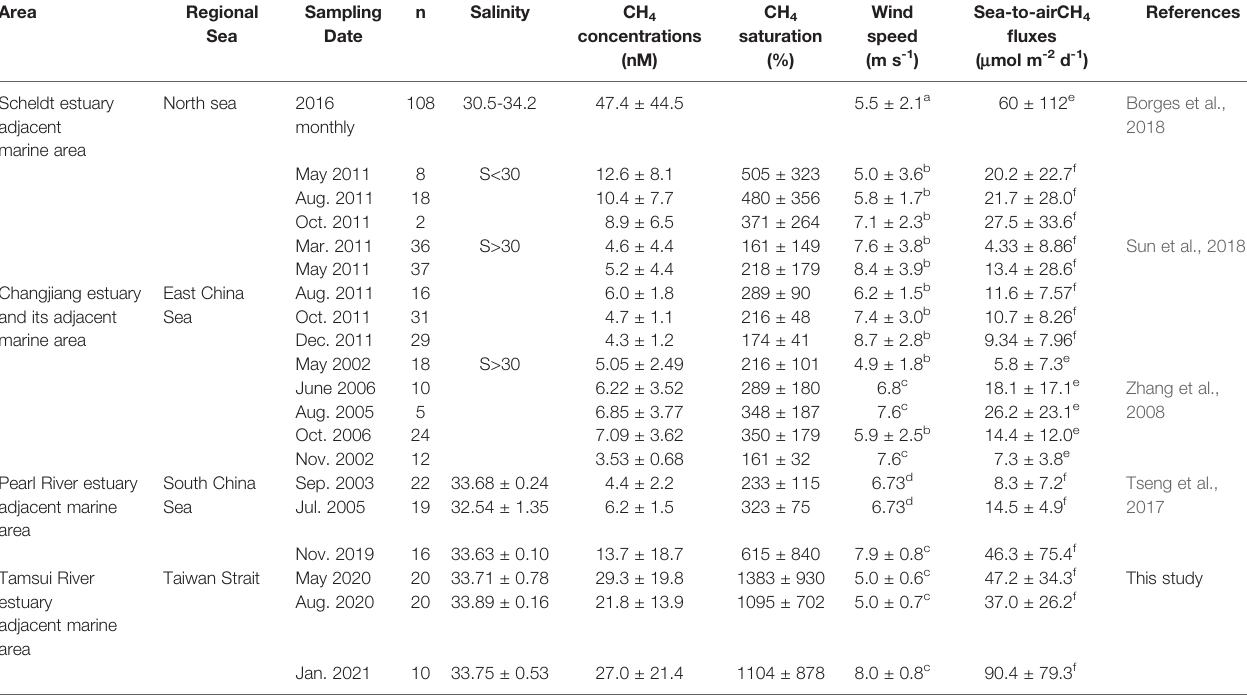
TABLE 3 | Compilation of surface CH 4 concentrations, saturations and fl uxes from the several estuaries and their adjacent marine areas.